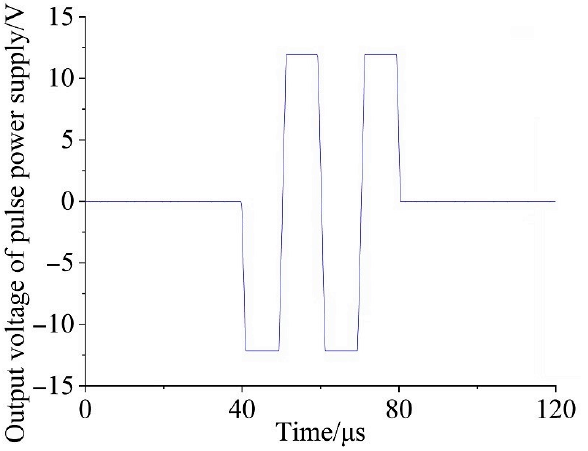
Figure 12. The output waveform of the pulse